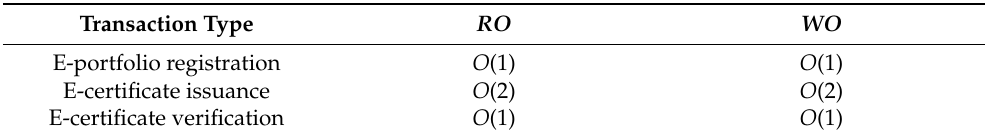
Table 6. Computational complexity of the core transactions interacting with the blockchain (read operation: RO , write operation: WO ).